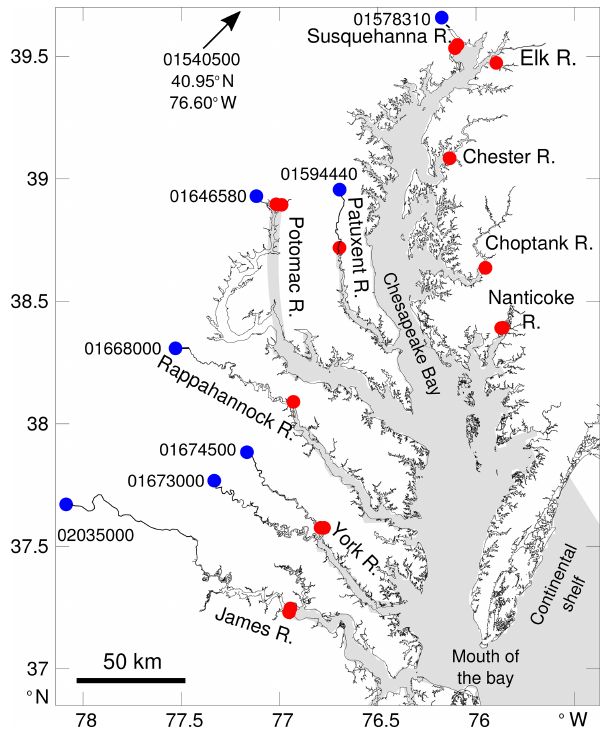
Figure 1. Map of the study area with the key tributaries labeled. The gray shading represents the model grid cells (see Da et al., 2018, for a map of the full model domain). Red circles represent the locations of riverine inflow in the model (10 rivers total). The largest rivers (Susquehanna, Potomac, York and James rivers) have their discharge distributed over two neighboring model grid cells (i.e., two overlapping red circles in the figure). Blue circles repre- sent locations where riverine alkalinity and DIC data are available. Each location is identified with an eight-digit number (see Methods